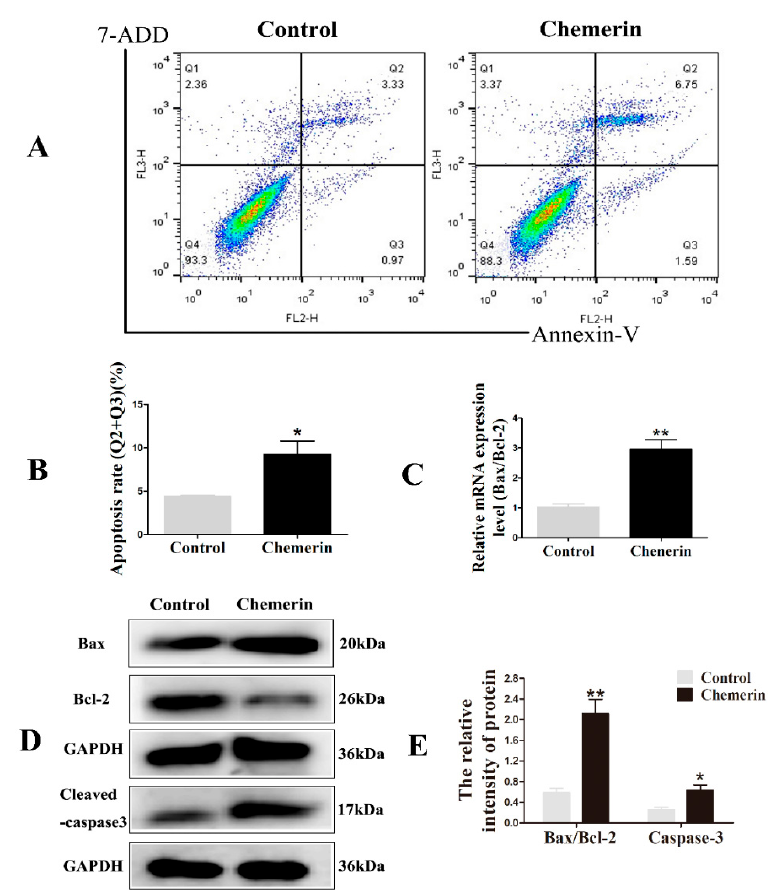
Figure 3. Chemerin-induced BMECs apoptosis in BMECs. Cells were stimulated with Chemerin for 24 h. ( A ) Analysis of apoptosis via flow cytometry. ( B ) Percent apoptosis was determined in Q2 + Q3. ( C ) The ratio of Bcl2-associated X and B-cell lymphoma-2 ( Bax / Bcl-2 ) was analyzed